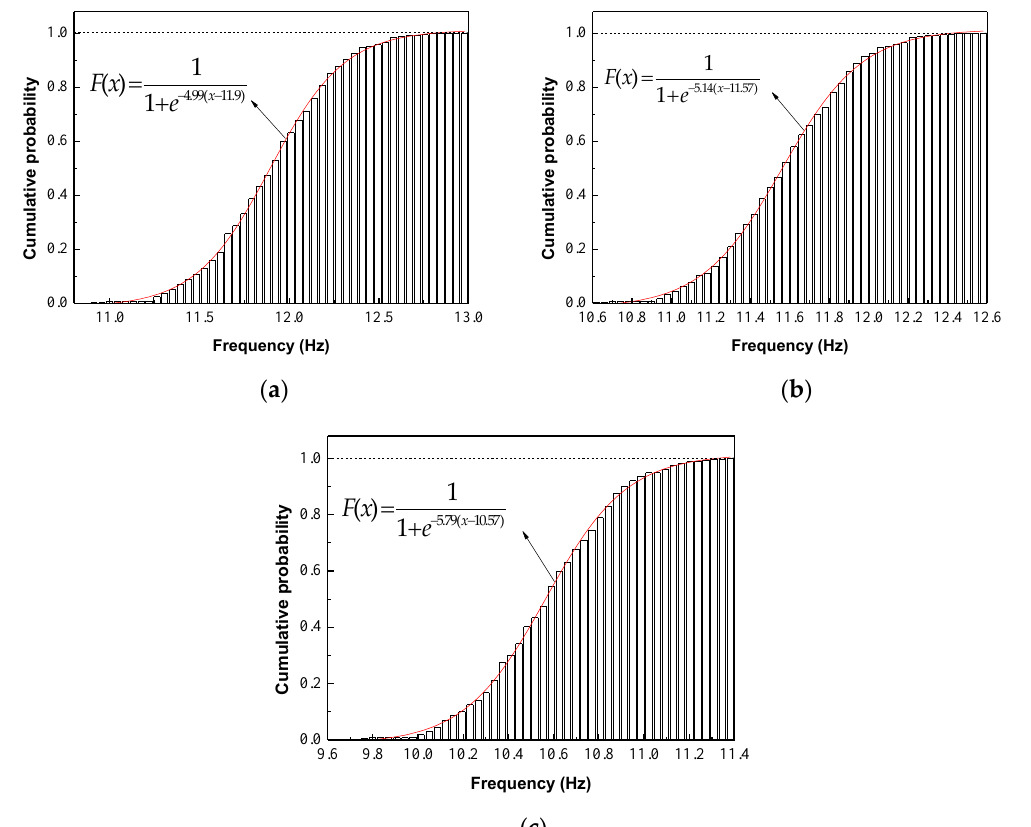
Figure 16. CDFs of the first natural frequencies of Model 2: ( a ) Initial guess; ( b ) 100th step; ( c ) 1000th step (optimal).